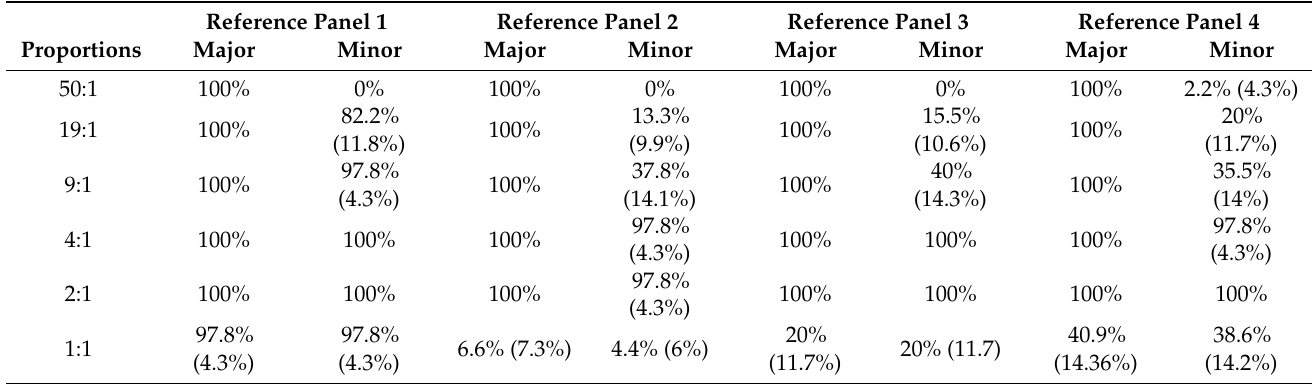
Figure 3. Histograms depicting the percent of mixtures (both minor and major contributors) phased correctly ( y -axis) using 4 different reference panels for all ratios ( x -axis). The vertical crossbars represent 95% confidence intervals. For descriptions of panels, refer to the methods section. Table 1. Phasing accuracy as it relates to different reference panels for all mixture ratios. The values in parentheses are standard deviations.